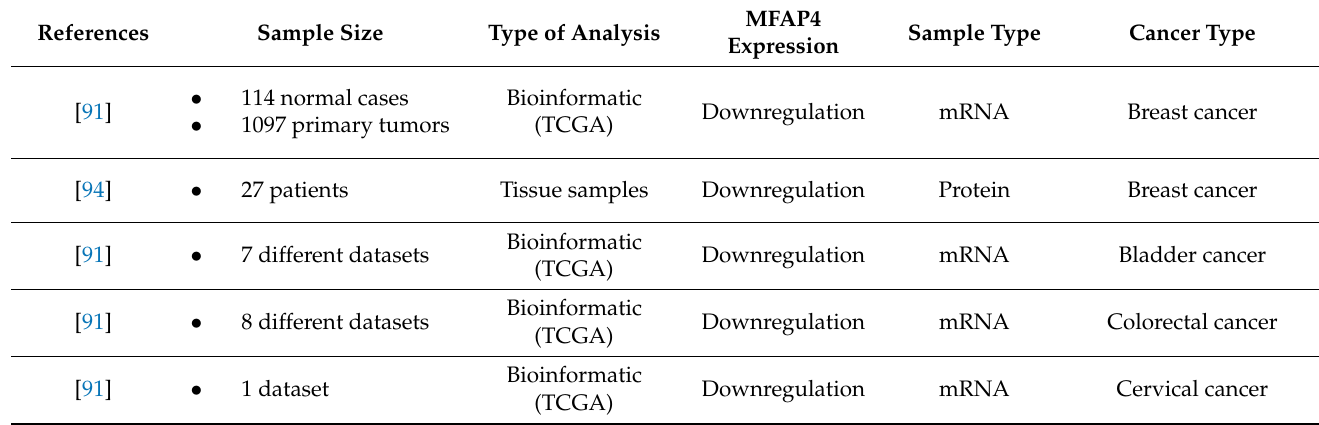
Table 1. Regulation of MFAP4 expression in different cancer